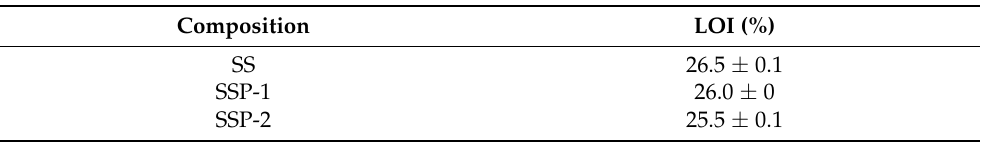
Table 2. Oxygen index of ceramicable silicon rubber composites.